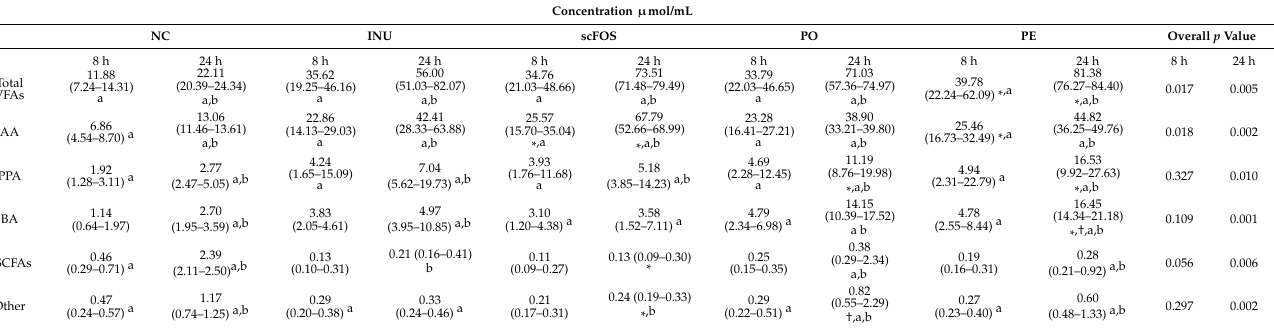
Table 6. Total short-chain fatty acids (TSCFAs) and SCFAs concentrations ( µ mol mL − 1 of sample), after 8 and 24 h of fermentation for the neurotypical children